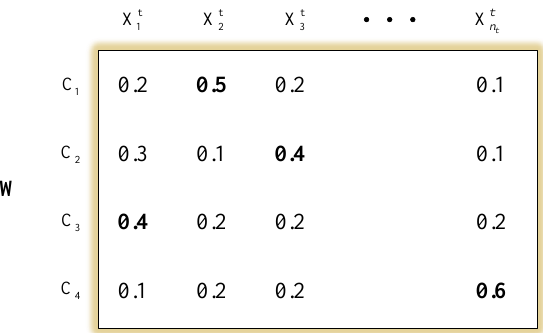
Figure 7. An example of the probability annotation matrix. The rows denote the class labels, and the columns denote the target samples. The entry value W ij indicates the annotation probability of x t belonging to class C i ; i = 1,2,3,4 and j = 1,2,..., n t . The class labels of x t j marked in bold